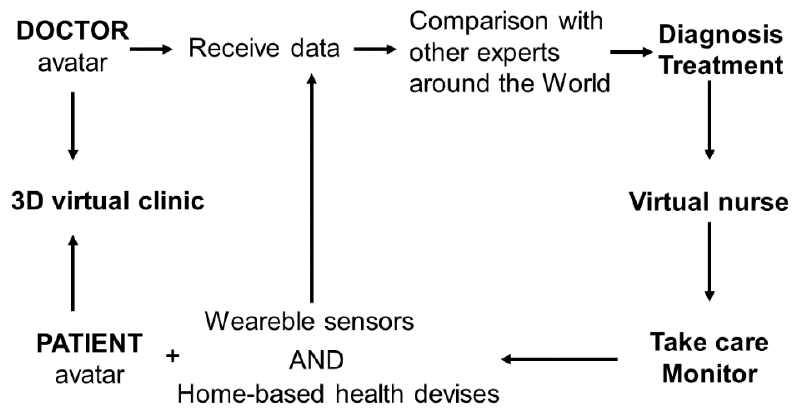
Figure 2. Representation of the possible virtual relationship between doctors and patients.